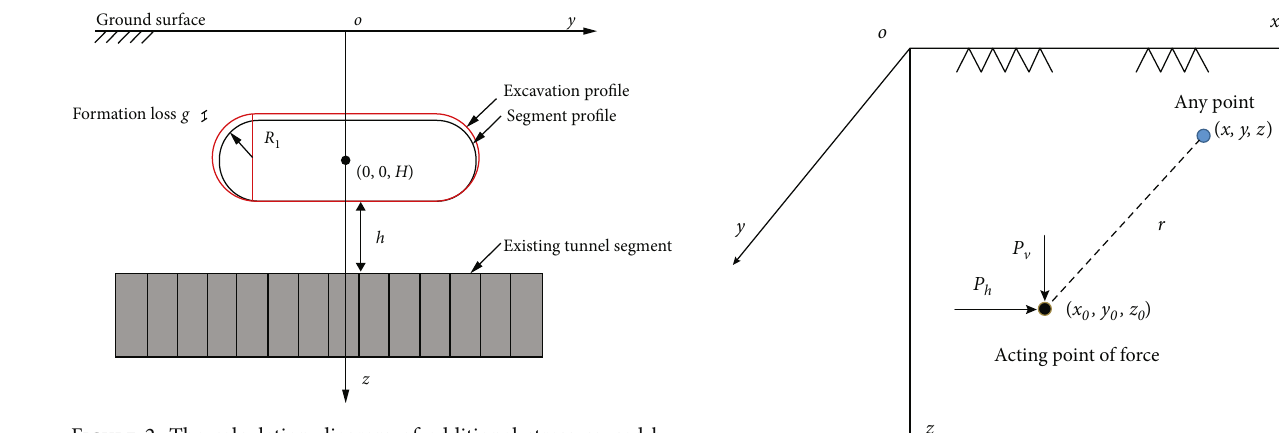
Figure 2: The calculation diagram of additional stress caused by stratum loss.